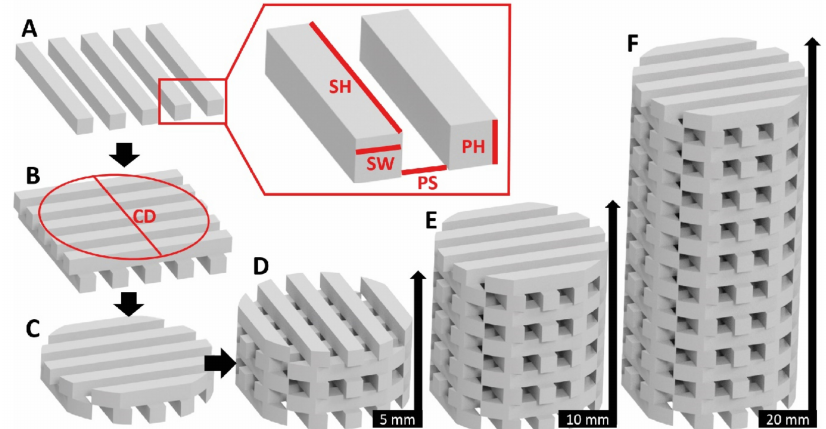
Figure 1. Scaffold test specimen geometrical design process to match theoretical values of porosity, heights and pore size: ( A ) the first layer was designed, the region of interest (ROI) of the struts that are created with a width (SW), length (SH) and a height (PH), as denoted by red lines. PS corresponds to the pore size and is equal to the pore height (PH). ( B ) A second layer is added by rotating the first one by 90 ◦ and placing it on top of it, a circumference with diameter (CD) is designed and everything outside it is removed producing ( C ). ( D – F ) The remained part is duplicated along the cylindrical principal axis ( z -axis) as required for the specimen height. The final specimen geometry with length of 5, 10 or 20 mm was exported for 3D printing as a STL file.